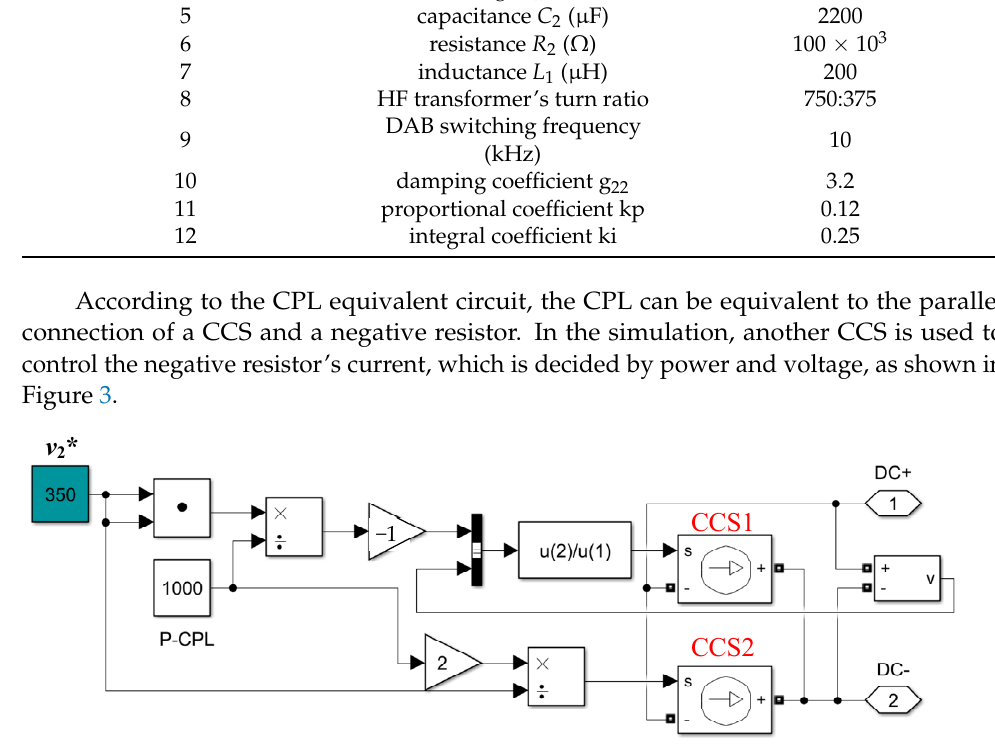
Figure 3. CPL simulation model.